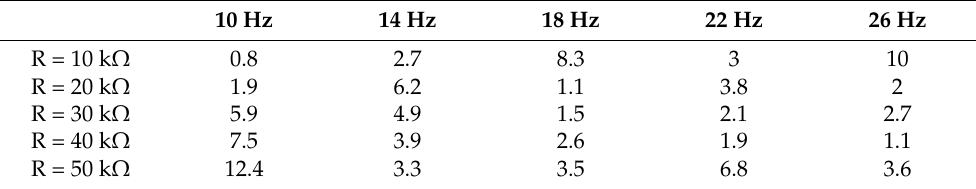
Table 4. Output voltage error of the two piezoelectric MFC films (%).